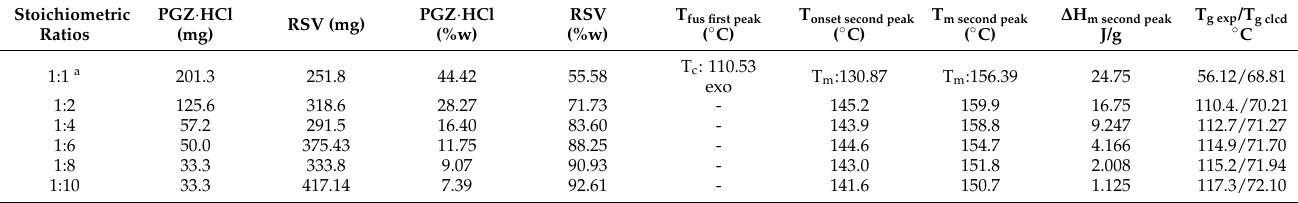
Table 3. Thermodynamic data of the different solid forms of PGZ · HCl-RSV at different stoichiometric ratios (1:1, 1:2, 1:4, 1:6, 1:8, and 1:10).